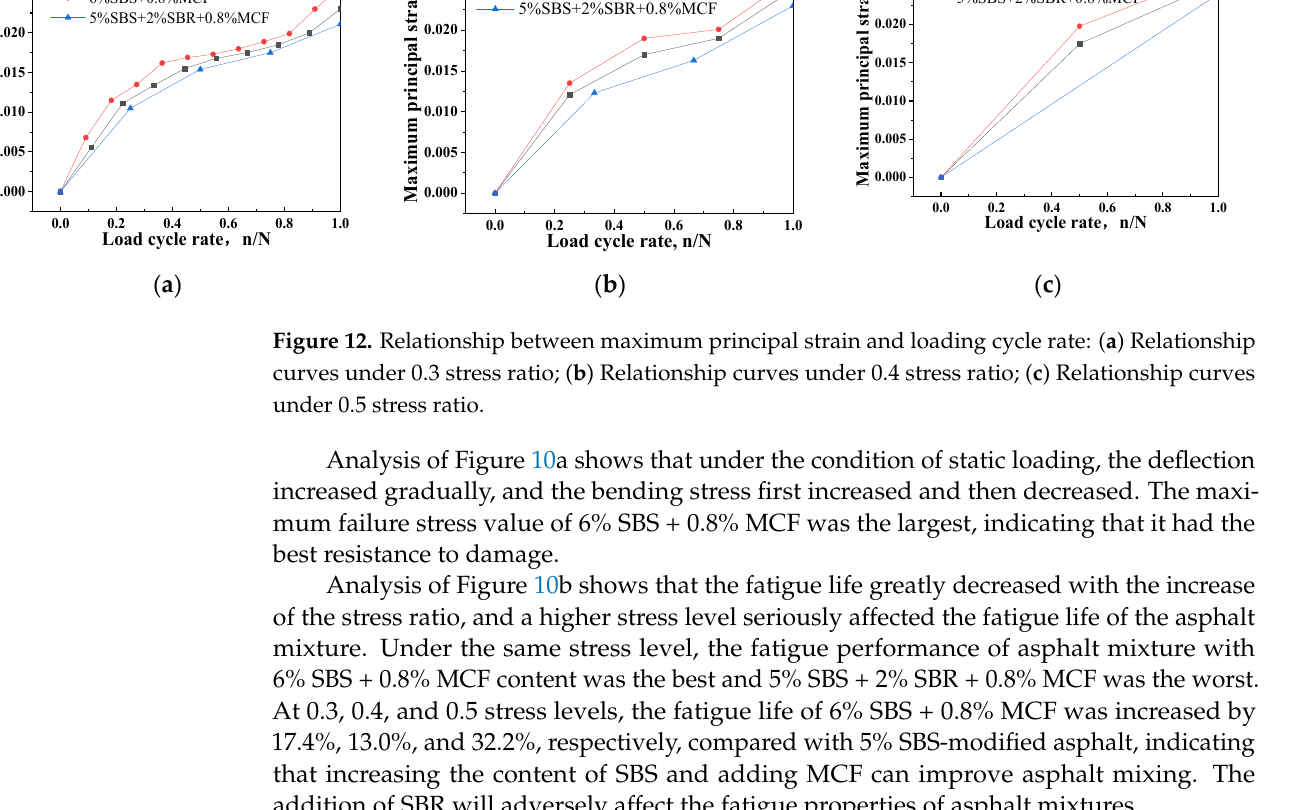
13 of 16 Figure 11. Strain cloud diagram of 6% SBS + 0.8% MCF asphalt mixture under different loading times in fatigue test. ( a ) loaded 0 times; ( b ) loaded 4000 times; ( c ) loaded 8000 times; ( d ) loaded 12,000 times; ( e ) loaded 16,000 times; ( f ) loaded 20,000 times. Analysis of Figure 10a shows that under the condition of static loading, the deflection increased gradually, and the bending stress first increased and then decreased. The max- imum failure stress value of 6% SBS + 0.8% MCF was the largest, indicating that it had the best resistance to damage. Analysis of Figure 10b shows that the fatigue life greatly decreased with the increase of the stress ratio, and a higher stress level seriously affected the fatigue life of the asphalt mixture. Under the same stress level, the fatigue performance of asphalt mixture with 6% SBS + 0.8% MCF content was the best and 5% SBS + 2% SBR + 0.8% MCF was the worst. At 0.3, 0.4, and 0.5 stress levels, the fatigue life of 6% SBS + 0.8% MCF was increased by 17.4%, 13.0%, and 32.2%, respectively, compared with 5% SBS-modified asphalt, indicat- ing that increasing the content of SBS and adding MCF can improve asphalt mixing. The addition of SBR will adversely affect the fatigue properties of asphalt mixtures. Analysis of Figure 11 shows that micro-cracks first generated at the initial stage of loading, and when the deformation accumulated to a certain extent, macro-fine cracks began to appear at the relatively weak position at the bottom of the specimen. With the increase of loading times, the cracks developed gradually. At the same time, the specimen can withstand the load cycle without breaking after the crack occurs because of the tough- ening effect of the fiber and the bonding effect of the asphalt. Due to the connection of the fibers, the cracks did not develop vertically upward along the original path, but tortuously cracked, indicating that the addition of micro-carbon fibers can significantly improve the